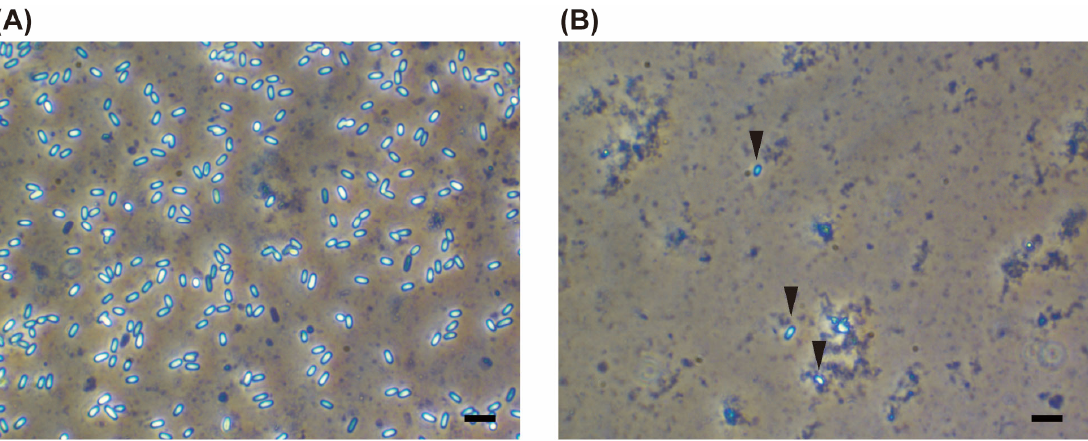
Table 1. List of bumblebee species collected in Biei and Kamifurano, Hokkaido and results of the PCR ampli fi cation of small subunit (SSU) rRNA and microscopy.